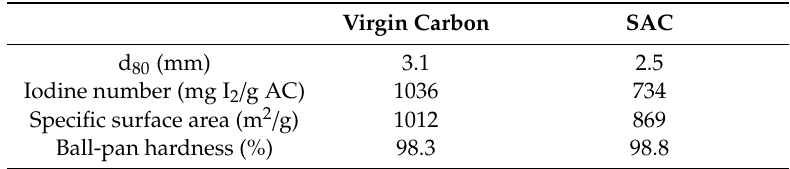
Table 1. D 80 (mm), iodine number (mg I 2 / g Ac), specific surface area (m 2 / g), and ball-pan hardens (%) of virgin carbon and spent activated carbon